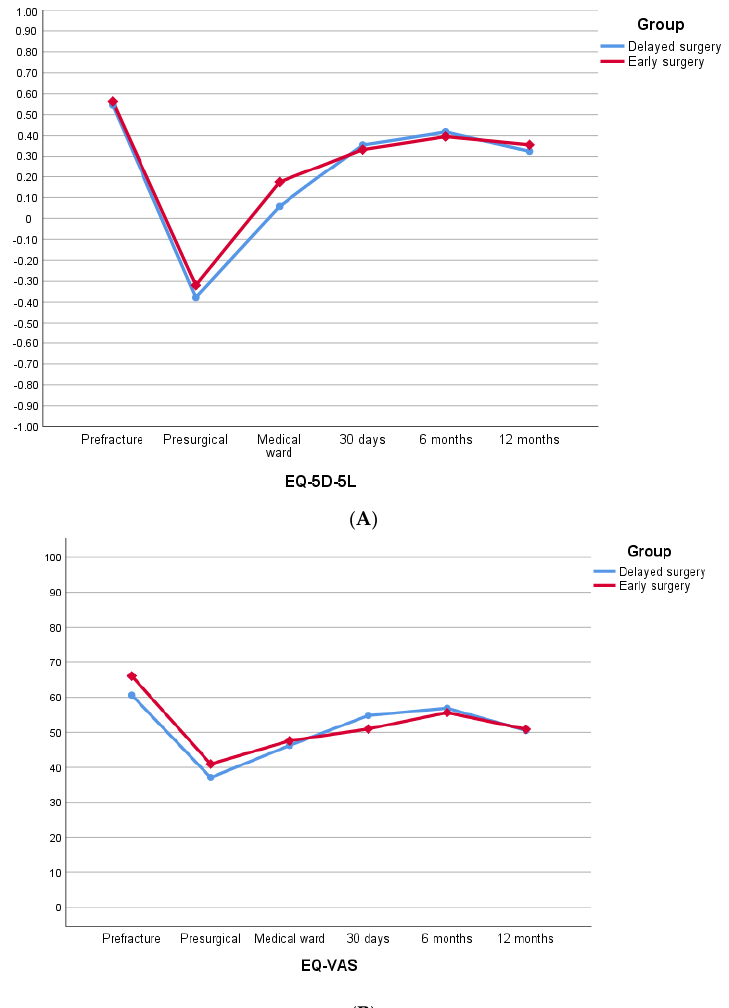
Figure 4. ( A ) EQ-5D-5L index assessment at different follow-up times. ( B ) EQ-5D VAS assessment at different follow-up times.